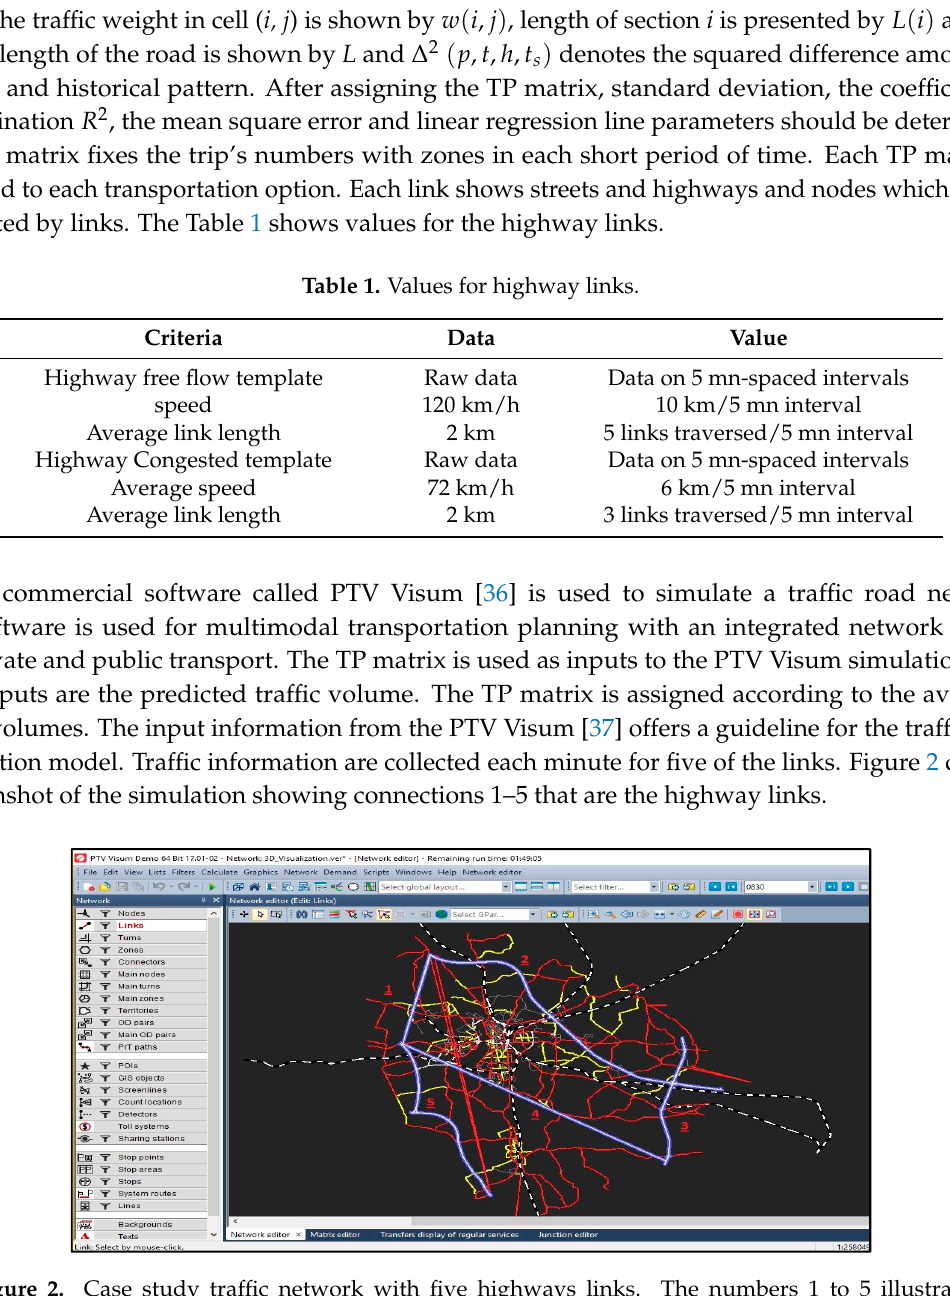
Figure 2. Case study traffic network with five highways links. The numbers 1 to 5 illustrate 5 highways links. 5 highways